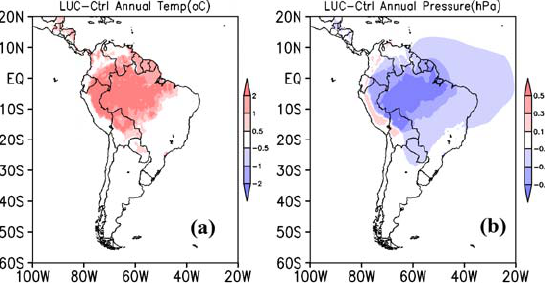
Figure 3. ( a ) Air temperature change, in °C, and ( b ) surface pressure change, in hPa, for LUC minus CRTL simulation.